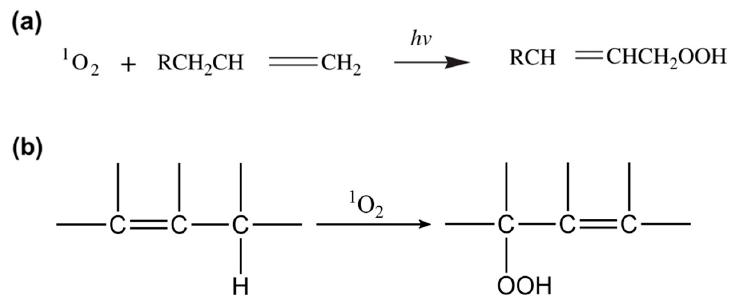
Figure 2. Singlet oxygen mechanism of oxidation. ( a ) Singlet oxygen oxidation of a vinyl group to form the hydroperoxide functional group (ROOH) [13]; reprinted from [13] with permission from Elsevier. ( b ) Singlet oxygen oxidation of an olefin group to form the hydroperoxide functional group (ROOH)